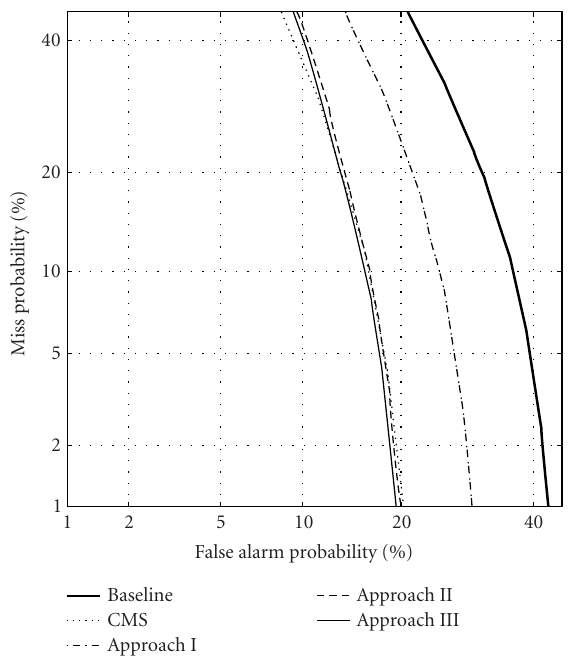
Figure 4: DET curves obtained by using the unseen handset cb3 in the verification sessions. Handsets cb3 and cb4 were used as the unseen